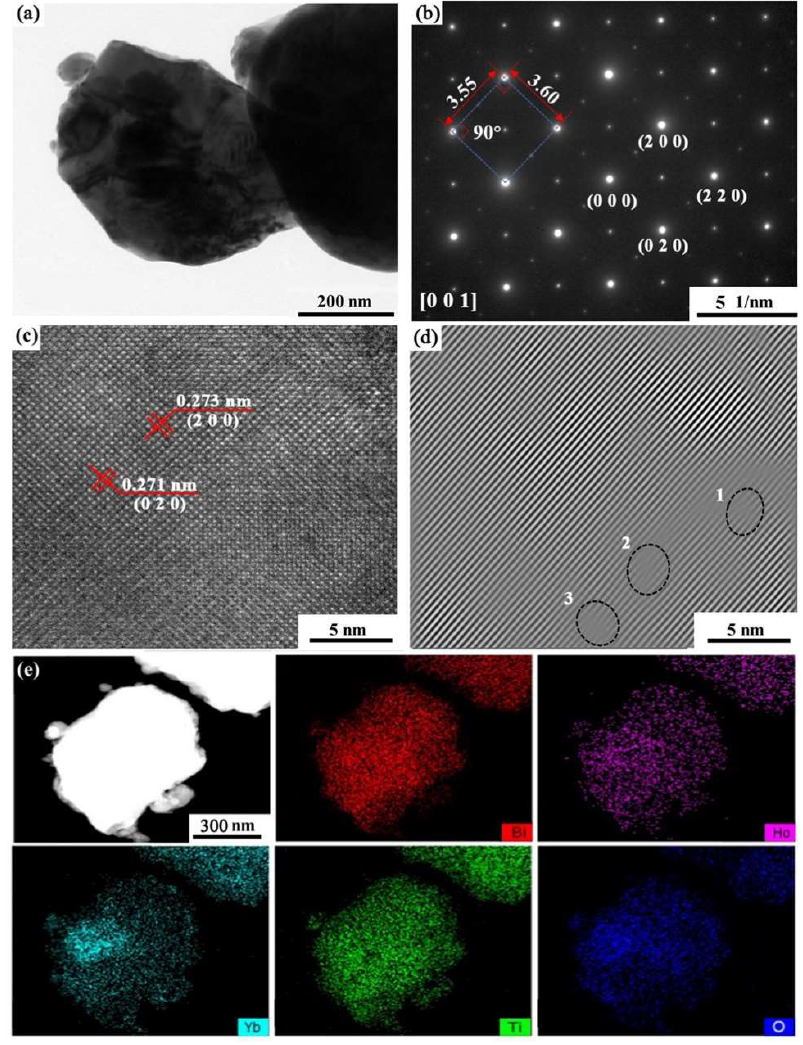
Figure 3. ( a ) TEM image, ( b ) SAED pattern, ( c ) HRTEM image, ( d ) fringes of (200) obtained by filtering, and ( e ) HAADF-STEM diagram and elemental distribution for BHYTO: 0.05Li samples.